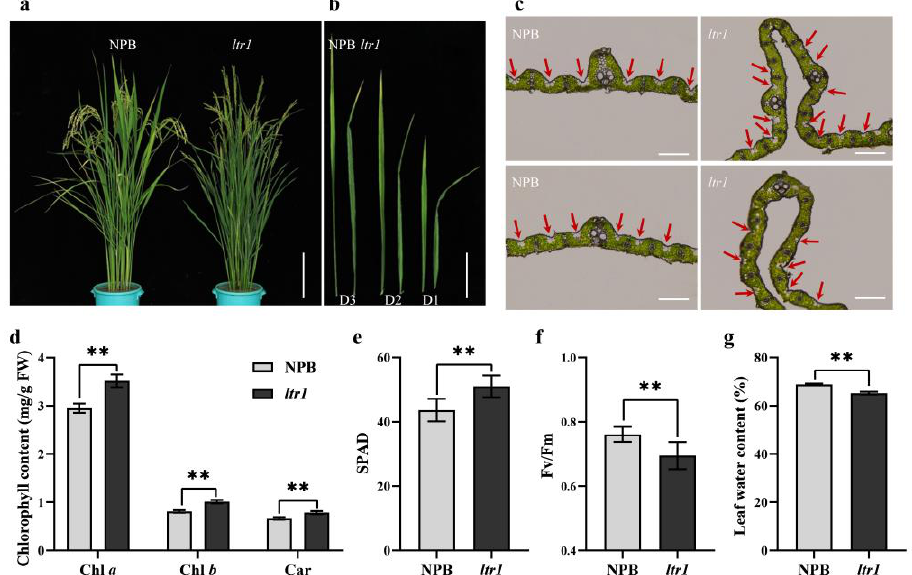
Figure 1. Phenotype analysis of NPB and ltr1 plants. ( a ) Plant morphology (bar = 20.0 cm), ( b ) leaf morphology (bar = 4.0 cm), and ( c ) observation of frozen sections of NPB and ltr1 (bar = 200 µ m), red arrows in ( c ) represent bulliform cells. ( d ) Chlorophyll content, ( e ) SPAD, ( f ) Fv/Fm, and ( g ) leaf water content of NPB and ltr1 . Data are given as means ± SD. Asterisks indicate significant difference based on the Student’s t -test: ** in the figure represents significant difference at p <